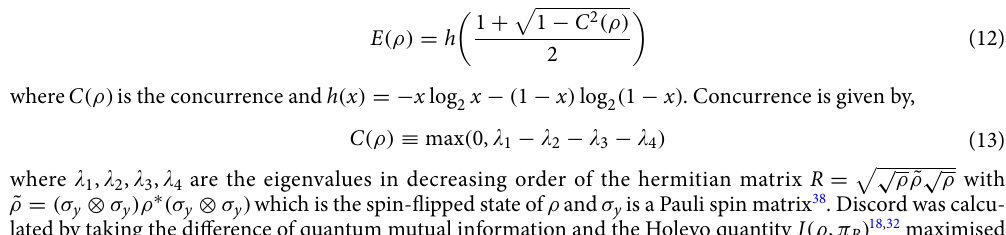
ψ ψ e ) e 1 / 4 with ψ being the − | − �� − | + −